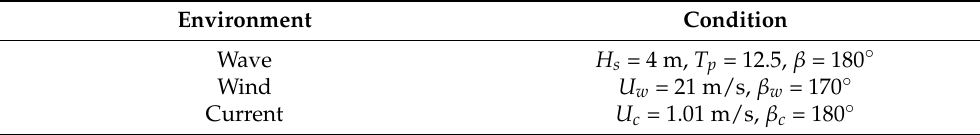
Table 3. Environmental condition in the simulation.